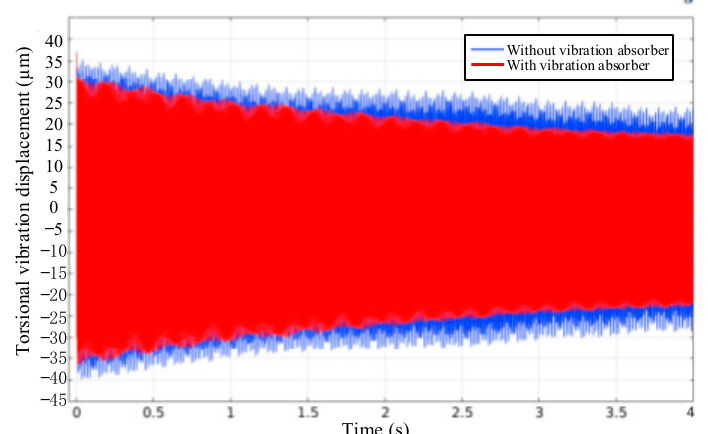
Figure 12. Vibration reduction effect of the internal resonance vibration absorber. It can be found that the amplitude of the gear’s torsional vibration increases signifi- cantly after considering the transmission error. The initial torsional vibration amplitude of the gear system is 68.5 µ m. The torsional vibration amplitude of the gear system with an internal resonance vibration absorber is reduced to 48 µ m within 2 s, 19.4% less than that without the vibration absorber (59.5 µ m). Within 4 s, the torsional vibration amplitude without the vibration absorber is reduced to 52 µ m, while the torsional vibration amplitude with the vibration absorber is reduced to 39 µ m, i.e., 25% less than that without the vibration absorber. Therefore, the torsional vibration energy can be transferred to and dissipated by the vibration absorber even after considering more complex factors.